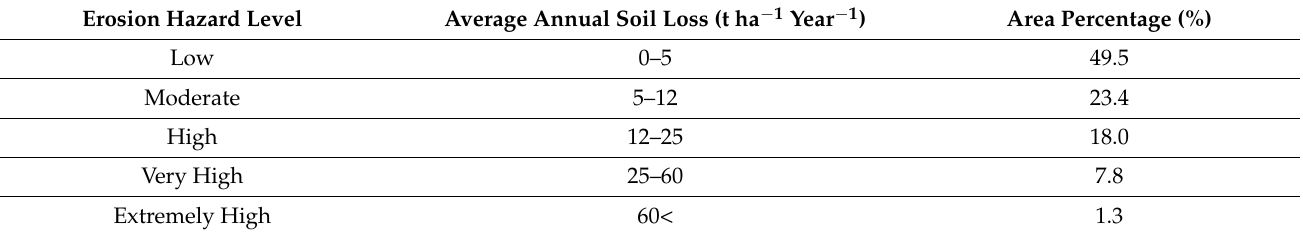
Table 2. Soil erosion hazard classes in the study area.